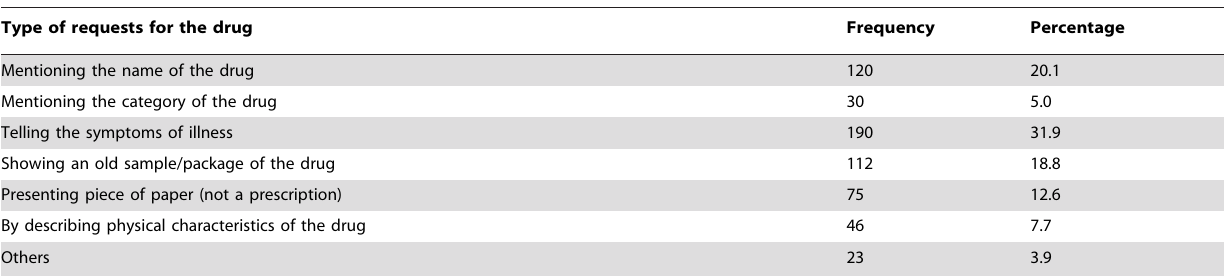
Table 3. Type of requests for self-medication (n=270).